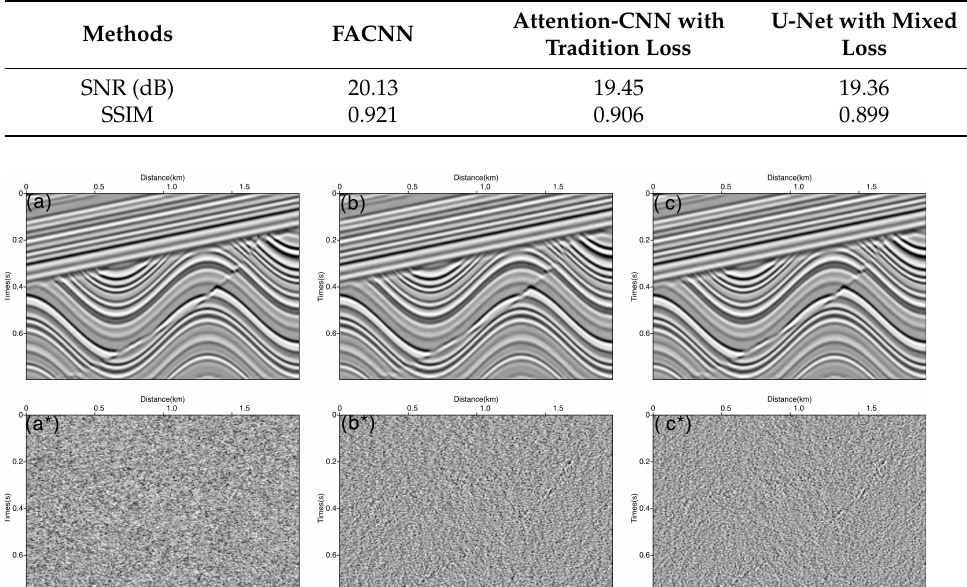
Table 4. The comparison of the SNR and SSIM for different methods.